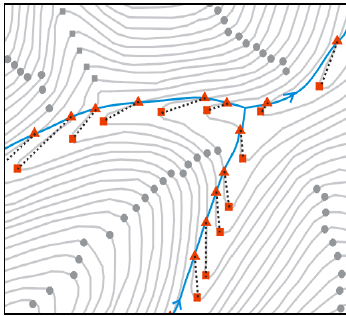
Figure 4. The matching relation between terrain valley points and intersection points of river network and contour